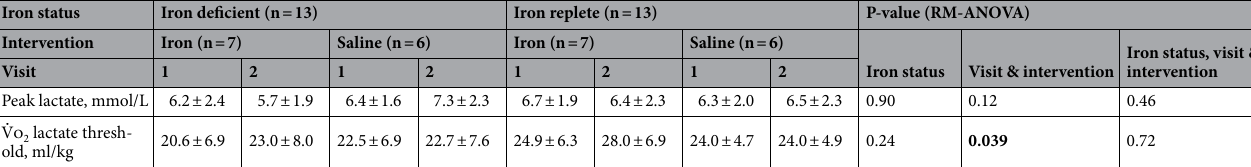
Table 5. Venous lactate kinetics during exhaustive exercise. P-values are given for: (i) the effect of baseline iron status; (ii) the interaction between visit and intervention; and (iii) the interaction between baseline iron status, visit, and intervention. Values are means ± SD. Statistically significant P-values appear in bold. The peak lactate is that measured at volitional